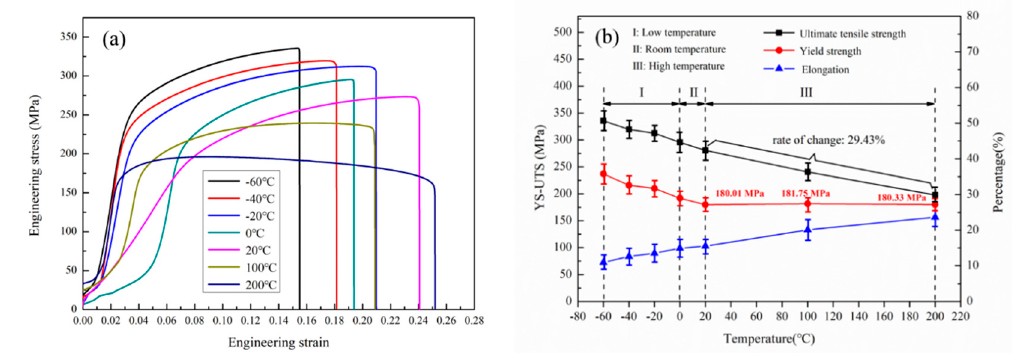
Figure 1. Engineering stress-strain curves of the alloy at different temperatures ( a ) and mechanical performance statistic results ( b ).